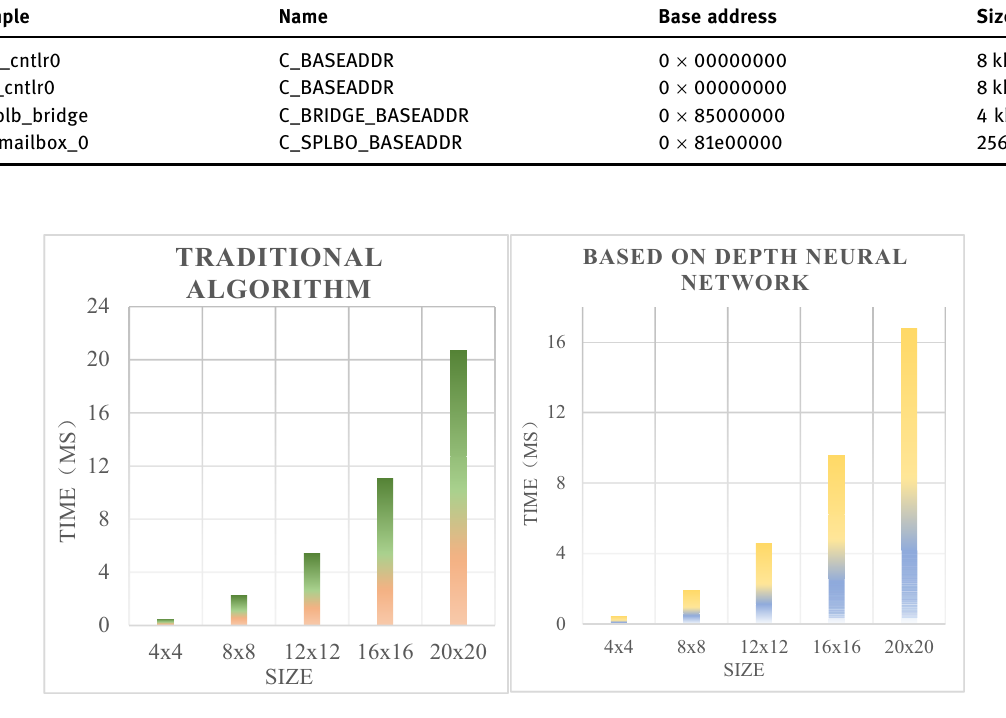
Figure 8: The calculation time of the two algorithms under the parallel